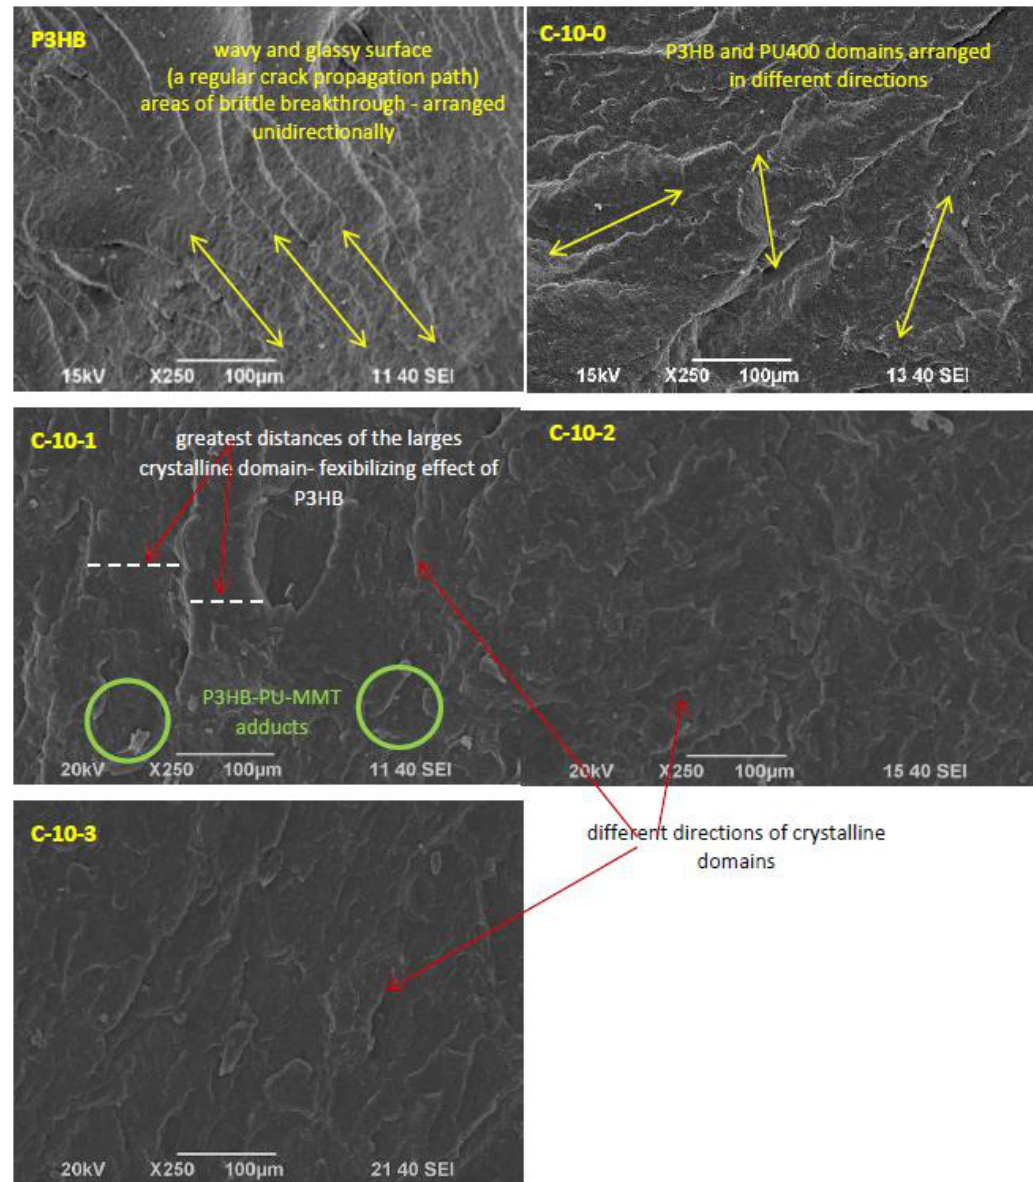
Figure 3. SEM micrographs of unfilled P3HB, P3HB loaded with 10 wt.%. PU400 (C-10-0), and its nanobiocomposites containing 10 wt.% of polyurethane (PU400) and 1, 2, and 3 wt.% of Cloisite ® 30B (designated as C-10-1, C-10-2, and C-10-3, respectively) at 250× magnification.